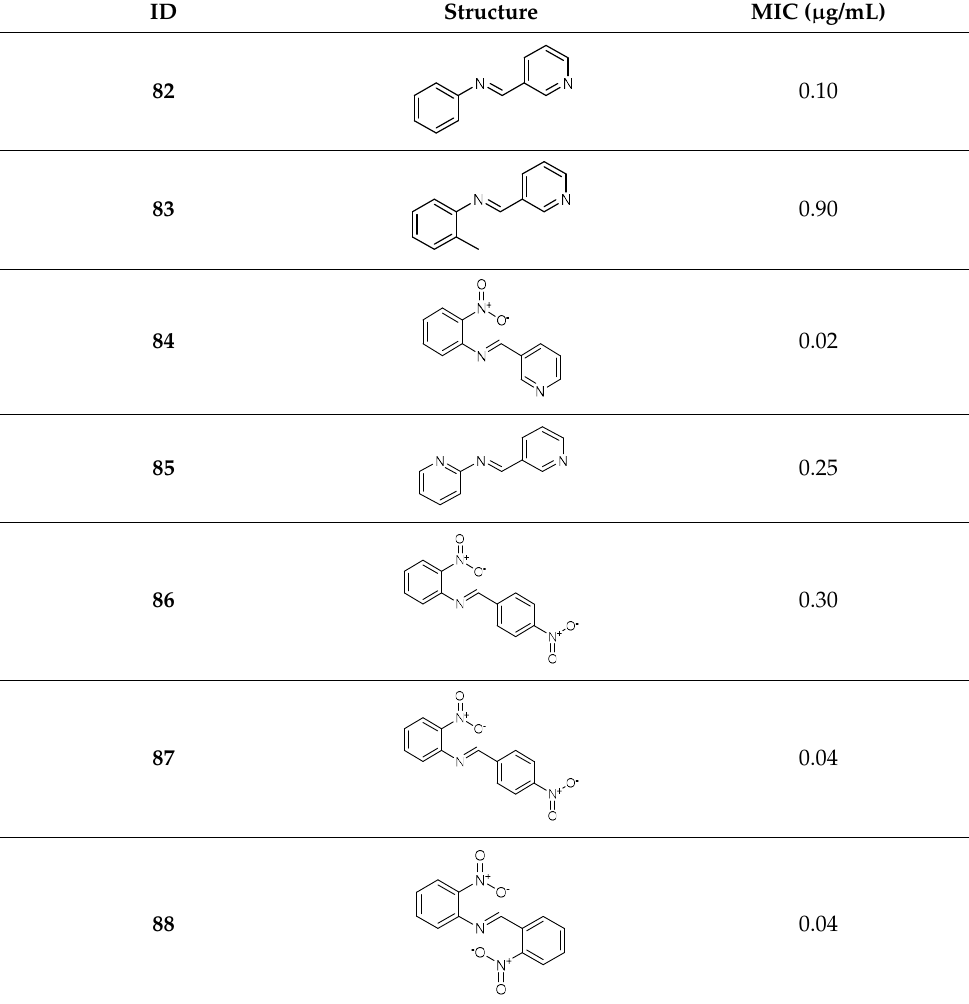
Table 11. M.I.C. values of Schiff base derivatives compounds tested against F.o.a.